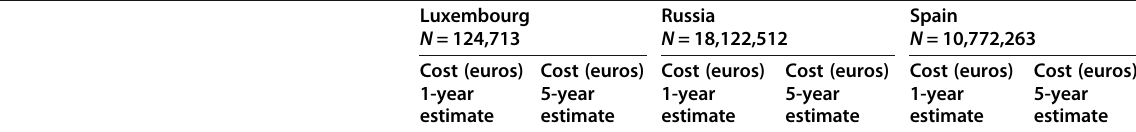
Table 6 Migraine costs (population